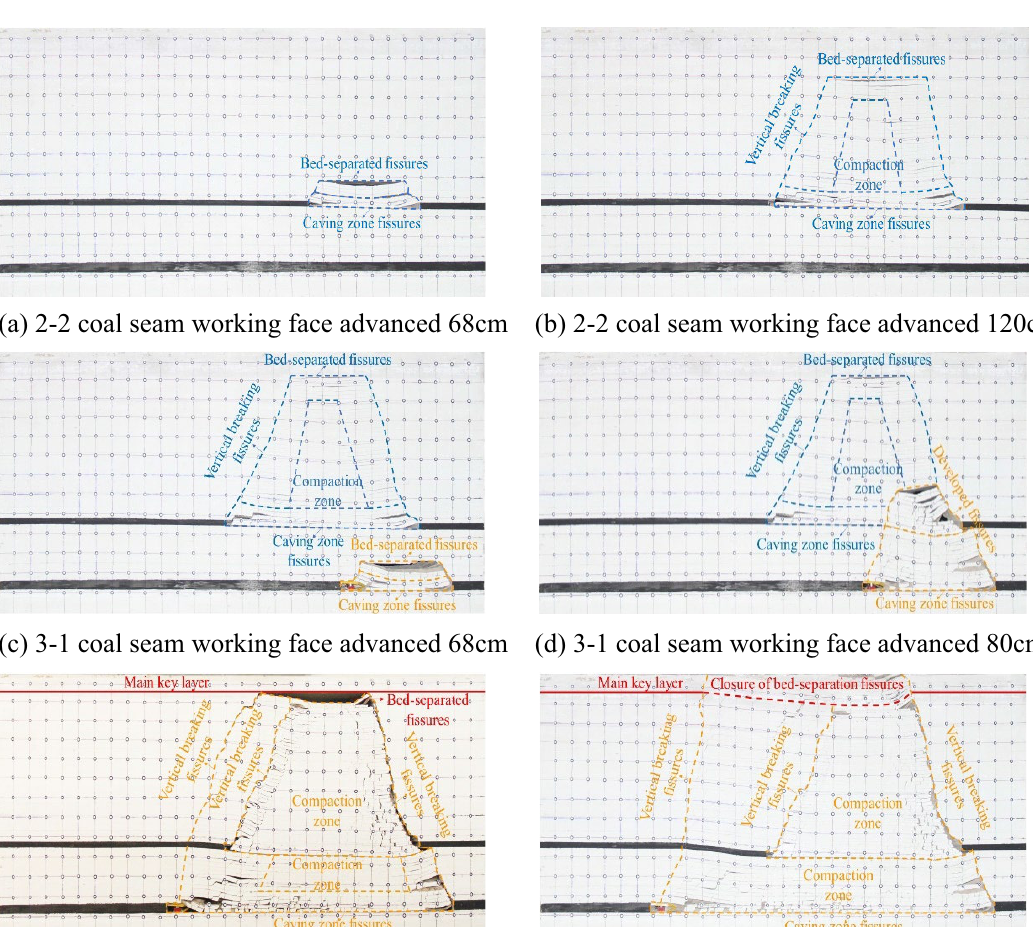
Figure 2. Overburden collapse diagram of working